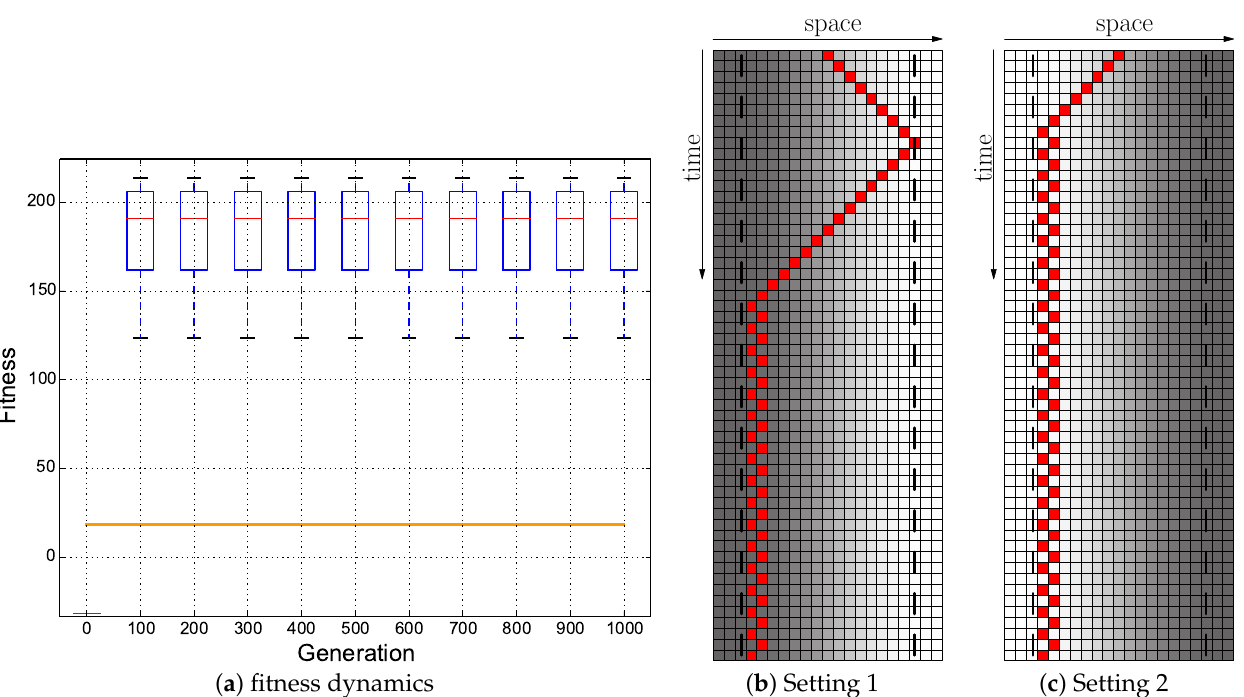
Figure 16. Evolutionary results of the Cumulative fitness regime starting with the hand-coded ANN (Figure 5a): fitness = F ( 0,0.01, 0 ) ; the minimum of both evaluations was used as the fitness value for each genome. ( a ) Fitness dynamics of the evolutionary population. The horizontal orange line indicates the maximum fitness achievable by a reactive Wankelmut controller. ( b , c ) Trajectory of the best performing genome in both environmental